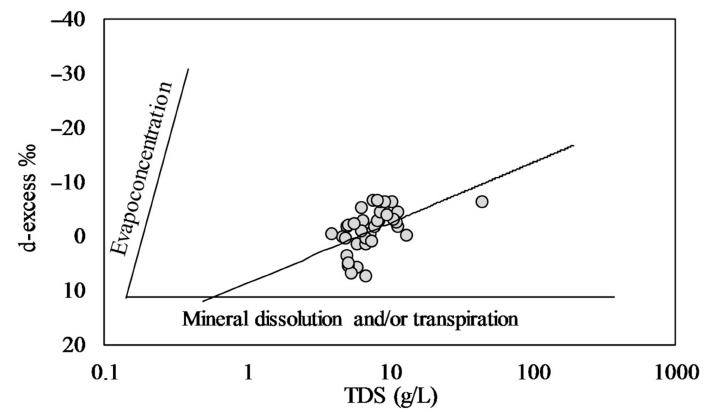
Figure 6. Relationship between total dissolved solids (TDS) and d-excess of groundwater samples according to Huang and Pang [36].